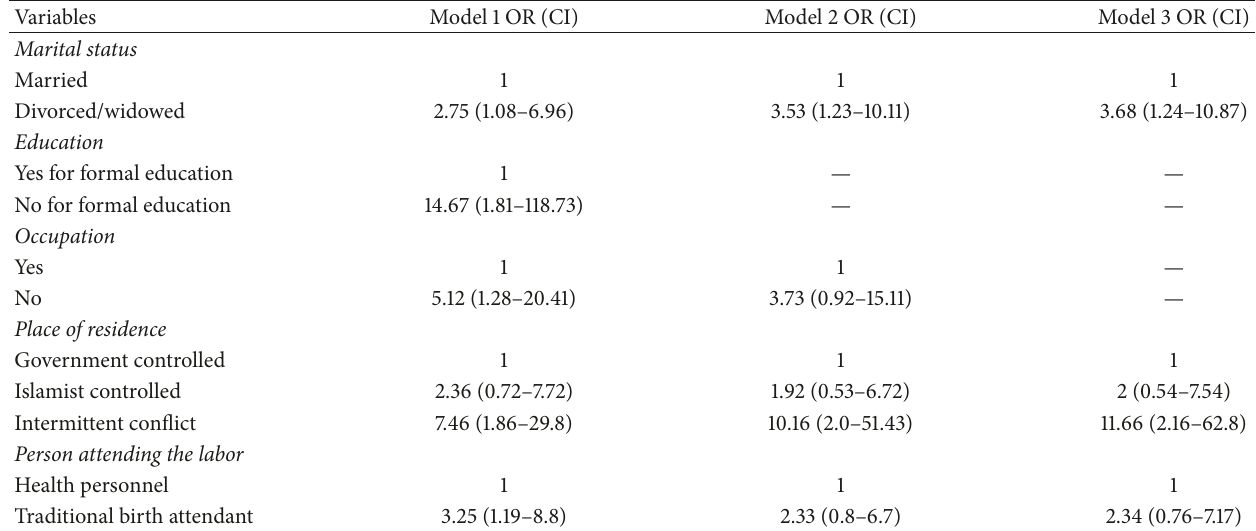
Table 3: Factors associated with waiting for fistula surgery ≥ 1